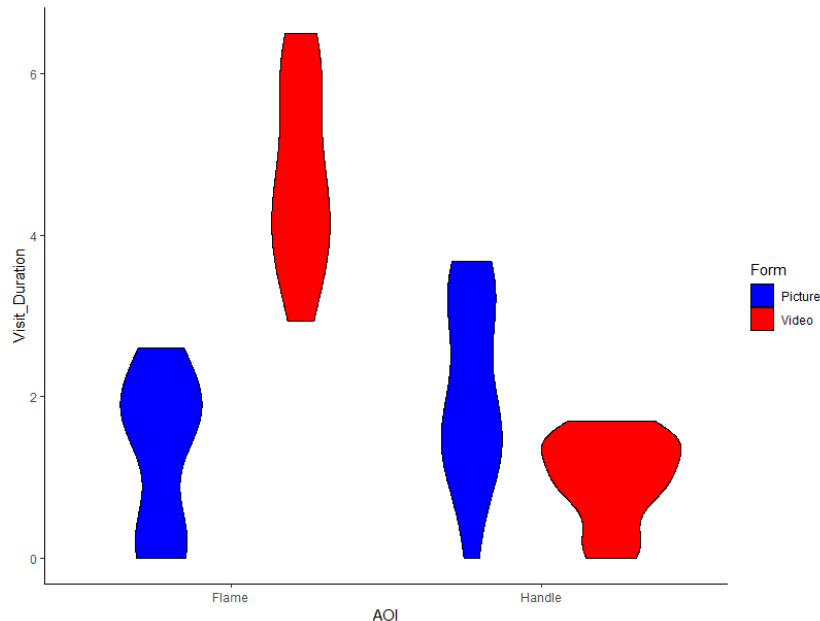
Figure 6. Violin plots highlighting the most significant differences on TVD Diff% between forms of representation for the product Flame.